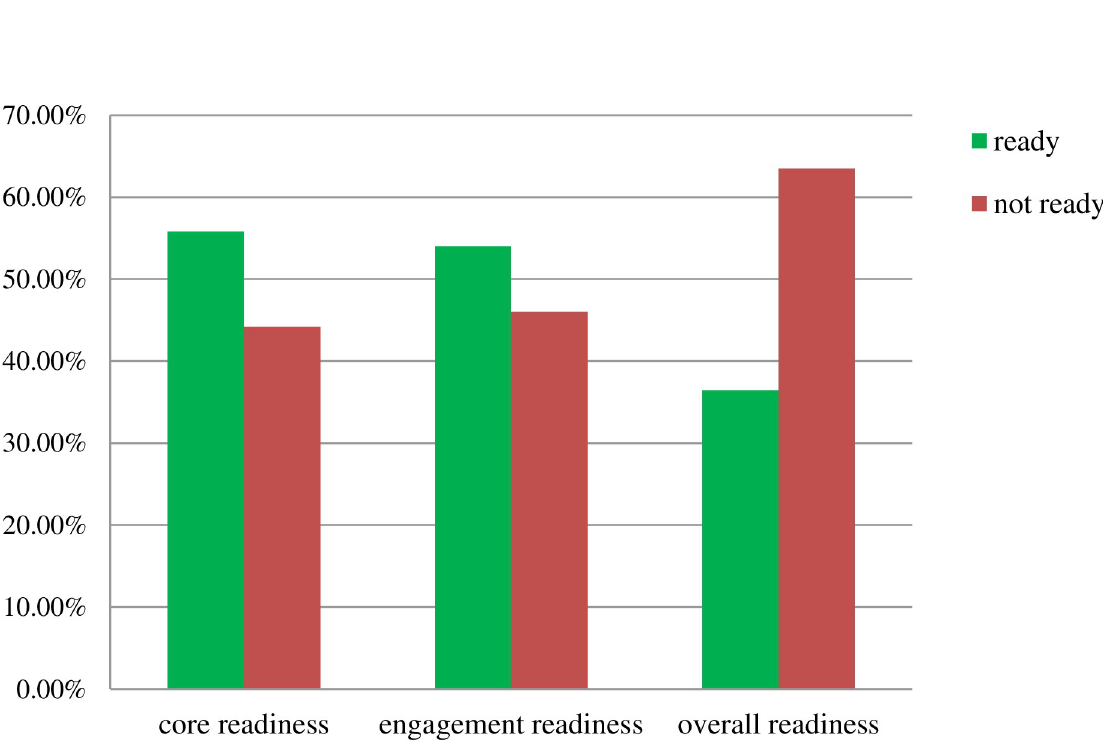
Fig 2. Health professional readiness to implement EMR in public general hospitals of Sidama region, Ethiopia, 2022.